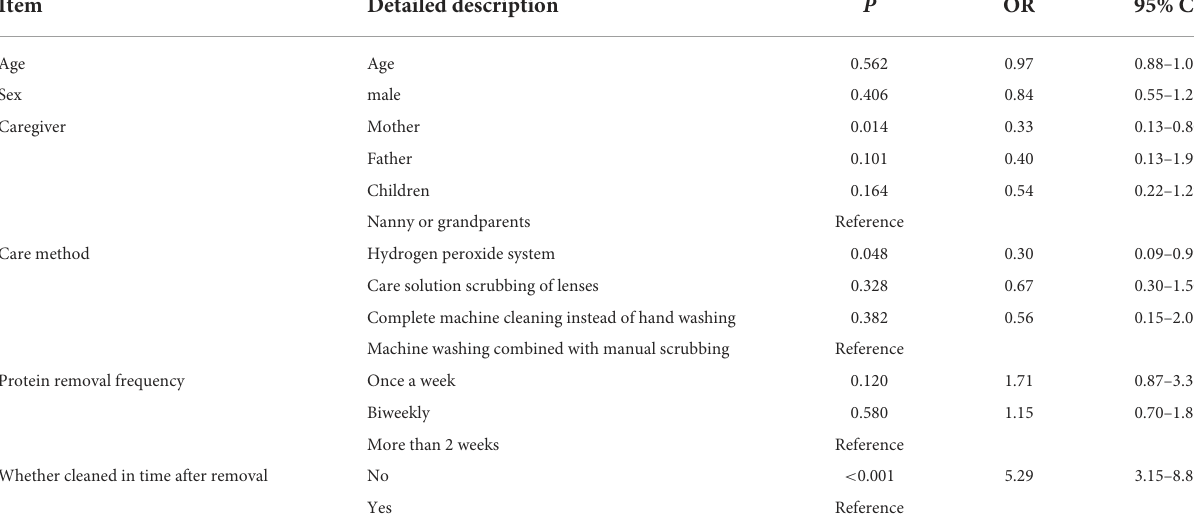
TABLE 5 Associations between the frequency of OK lens breakage and the daily care